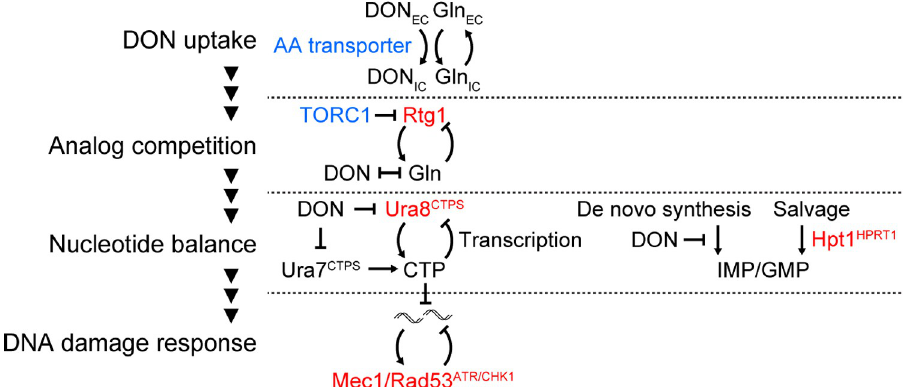
Fig 8. Hierarchy of pathways determining glutamine analog sensitivity. Sensitivity towards the glutamine analog DON is modulated by separable pathways at distinct levels: DON toxicity requires amino acid transporters which likely promote its uptake. Intracellularly, TORC1-regulated glutamine synthesis counteracts DON by producing its structural competitor. At the level of nucleotide synthesis, the direct DON target CTP synthase is actively restored through inducible expression of the URA8 gene to enhance CTP synthesis, whereas purine salvage represents the strategy to counteract purine de novo synthesis blockage. The DNA damage response acts downstream of these mechanisms and prevents DON-induced chromosome breakage. DON resistance and sensitizing genes are shown in red and blue, respectively.